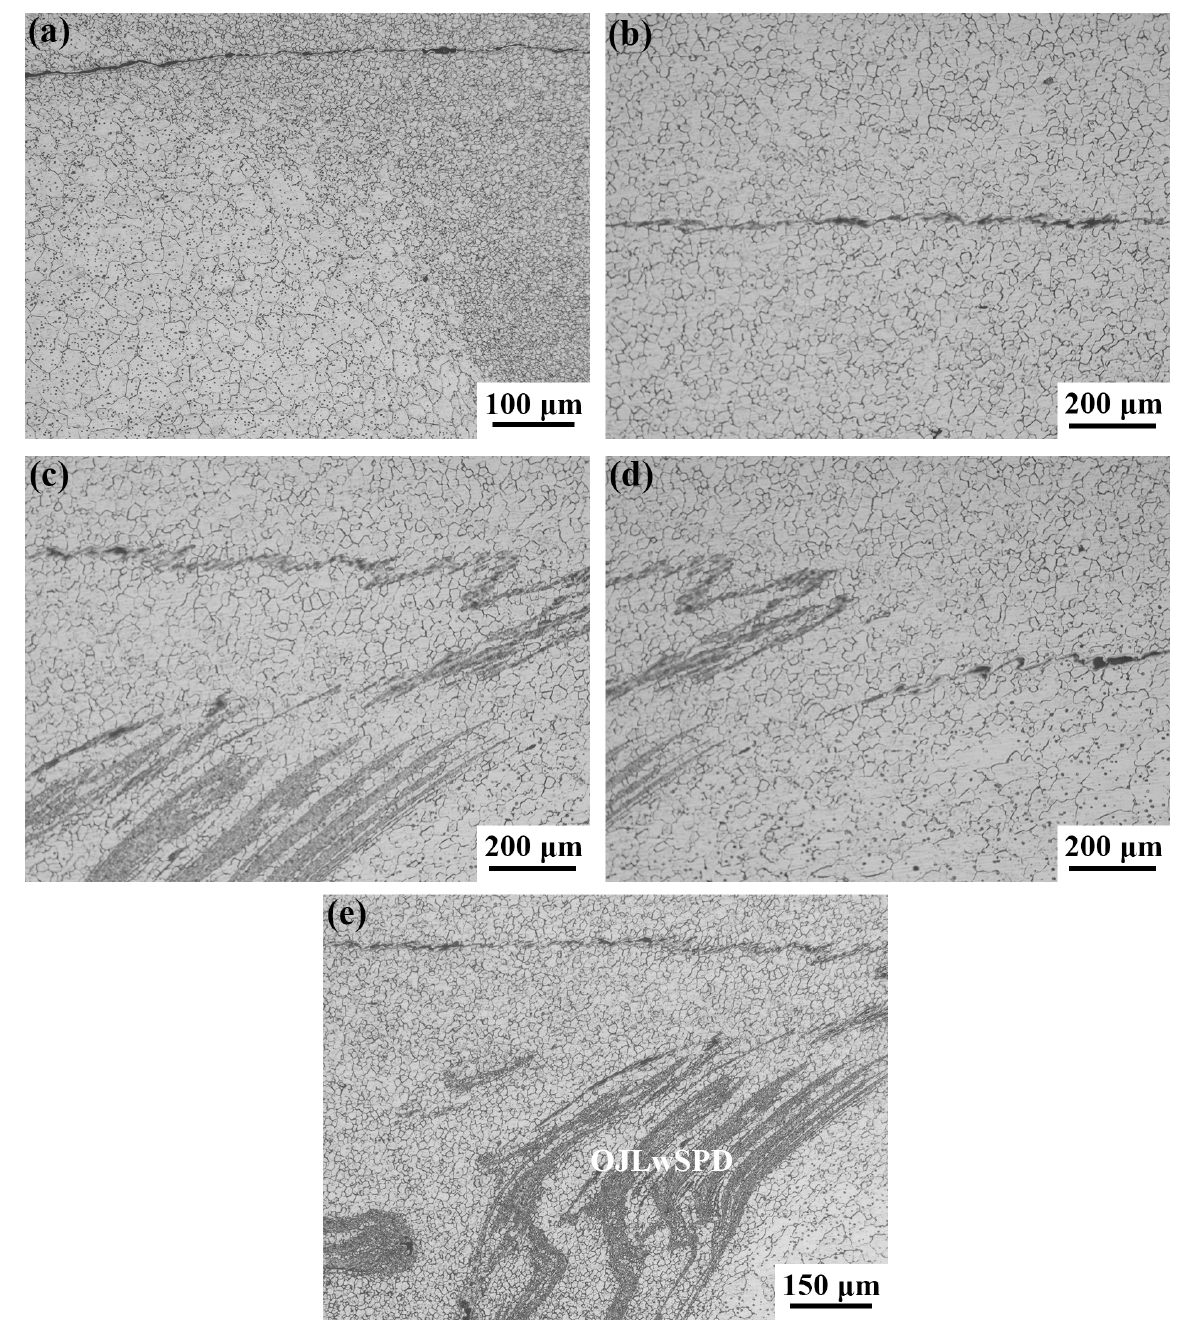
Figure 4: Magnified morphologies of (a) region A, (b) region B, (c) region C, (d) region D and (e) region E of joint in Figure 3a.